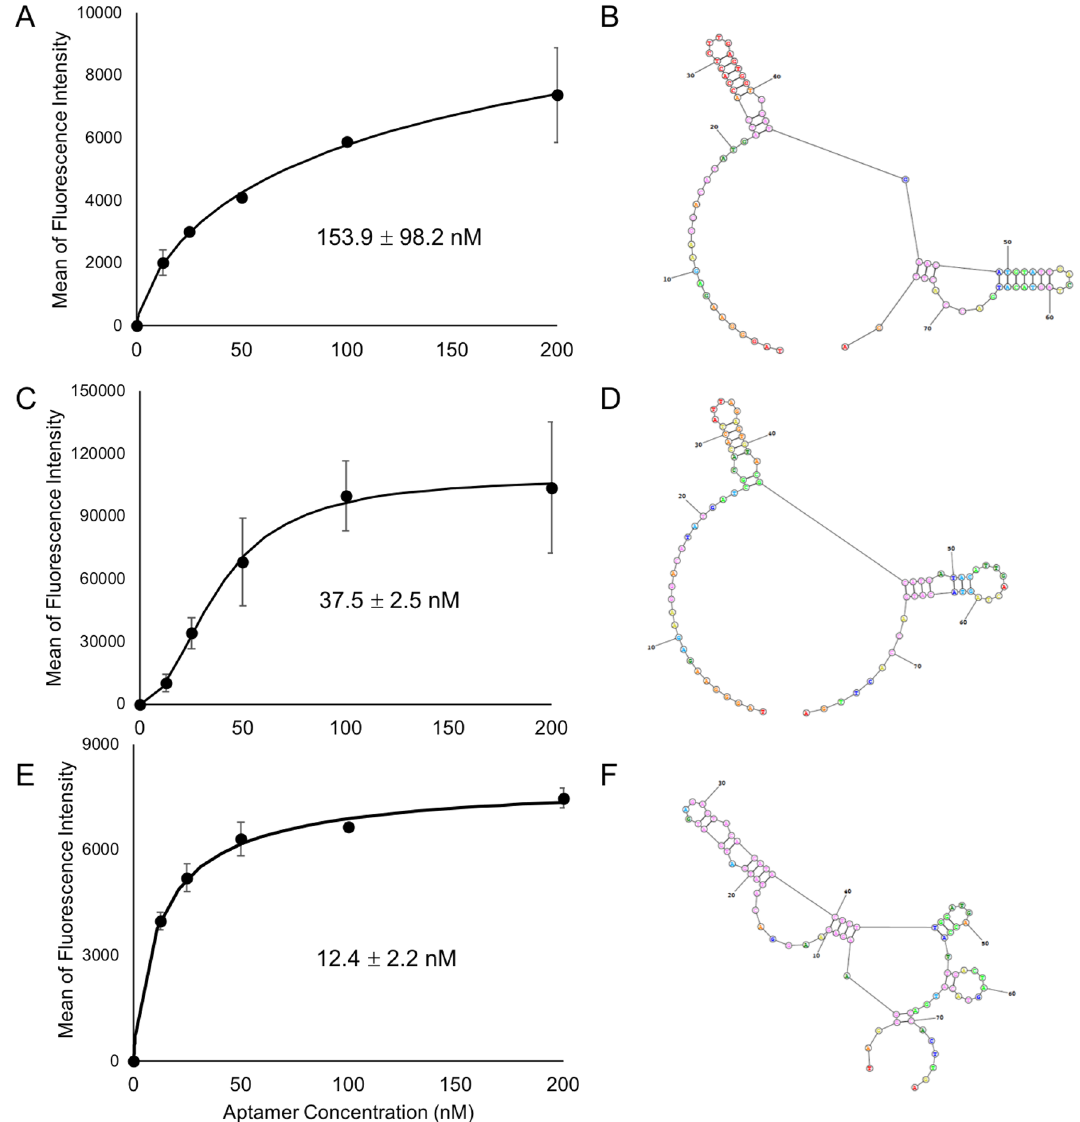
Figure 3. Binding curves of fluorescein labeled aptamers to MLL-AF9 RAS (MA9Ras) target cells. ( A ) KGE01 Kd curve: MA9Ras cells were incubated with increasing concentrations (nM) of KGE01 then were evaluated by flow cytometry. ( B ) The predicted secondary structure of KGE01 aptamer using RNA structure software. ( C ) KGE02 Kd curve: MA9Ras cells were incubated with increasing concentrations (nM) of KGE02 then were evaluated by flow cytometry. ( D ) The predicted secondary structure of KGE02 aptamer using RNAstructure software, a freely available web-based program that allows for the secondary structure prediction of single stranded DNA and RNA. ( E ) KGE03 Kd curve: MA9Ras cells were incubated with increasing concentrations (nM) of KGE03 aptamer using RNA structure software. To calculate the apparent Kd, the mean fluorescence intensity of the aptamer-cell dissociation vs concentration was fit to the equation Y = Bmax X/(Kd + X). The Kd graphs are the average of the three trials. Values are shown as means ± majority of the fluorescence signal is lost (Fig. 5B), suggesting that the associated target for the aptamer is likely membrane-bound. We confirmed these observations by confocal microscopy. Once again, fluorescence from tagged-KGE-02 can be observed with a punctate localization surrounding the cells (Fig. 5D) which is mostly, but not completely, lost after DNA nuclease treatment (Fig. 5E). This fluorescence was notably absent when the cells are treated with tagged-scrambled sequence (Fig. 5F and Figure S6). Having determined its selectivity to the target and gathered some information about the potential location of the cognate target, the next step was to truncate to a shorter sequence to lower the cost of synthesis and to perhaps increase cell uptake in future applications. Truncation of KGE02 and assessment of their binding abilities. Once KGE02 was proven to be specific, the next step was to truncate the 76-base sequence to create a smaller binding sequence. Truncated sequences were created based on the predicted three-dimensional structure (Fig. 3B), which shows two hairpin